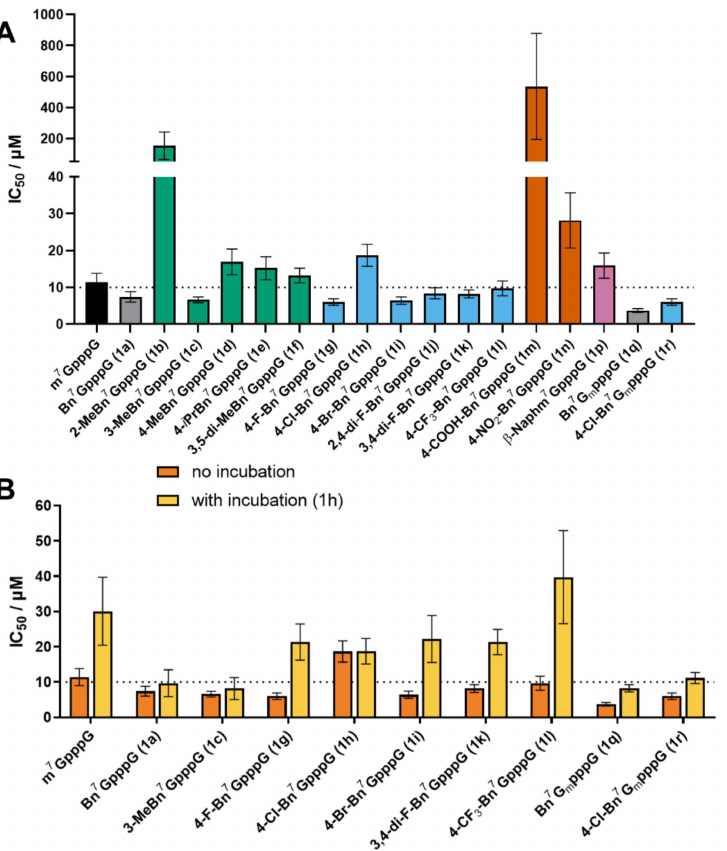
Figure 5. Translation inhibition by novel cap analogs in RRL. ( A ) IC 50 values of all tested caps measured in conditions without cap pre-incubation; ( B ) Comparison of IC 50 values obtained from two experimental variants (w/o cap pre-incubation and with 1 h incubation). The numerical values